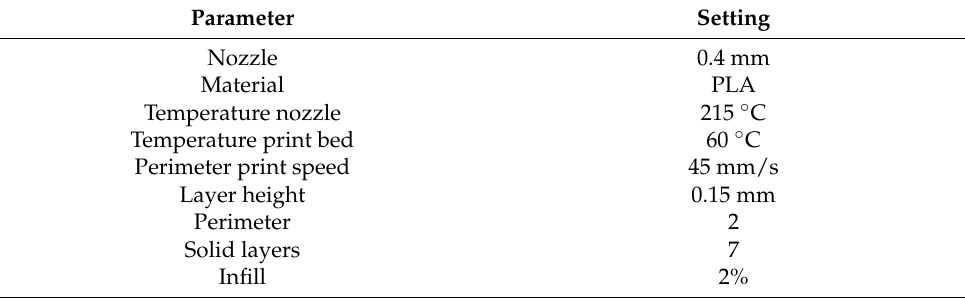
Table 3. 3D printing